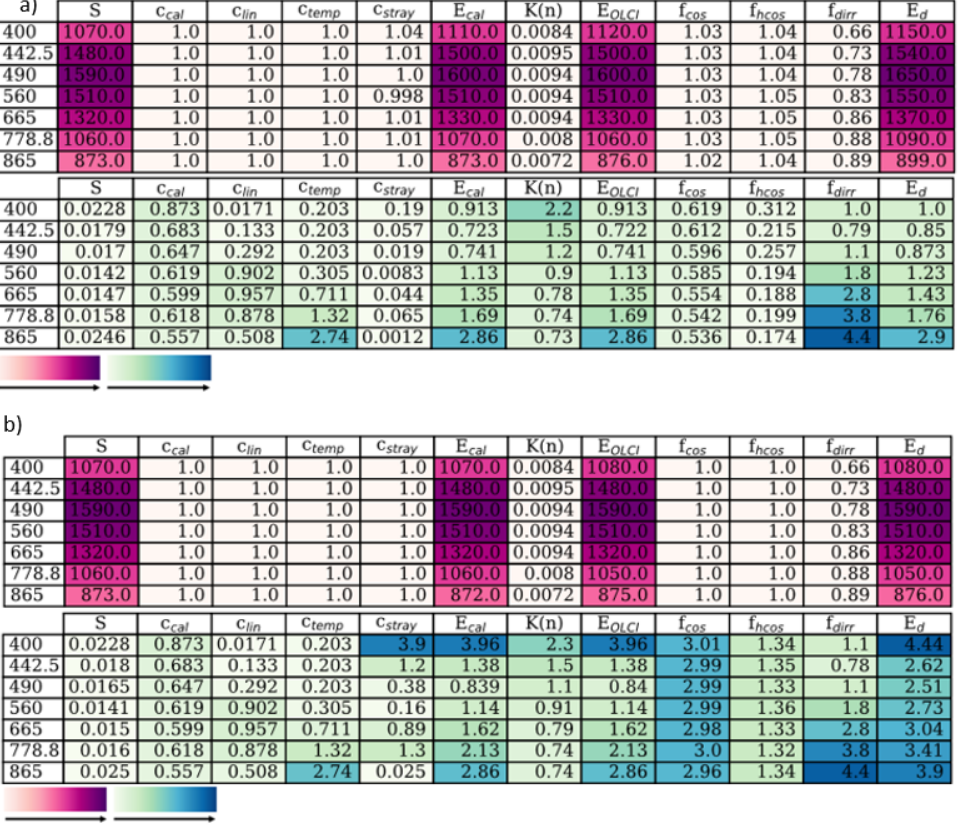
Figure 10. Irradiance MCM outputs. ( a ) Ideal case results. The mean (top panel) and standard uncertainty as a percentage of the mean (second panel) of each variable. This is shown for all OLCI bands of interest and relates to cast 1. The colour code intensity indicates the magnitude, ( b ) Non-Ideal case results. The mean (third panel) and standard uncertainty as a percentage of the mean (lower panel) of each